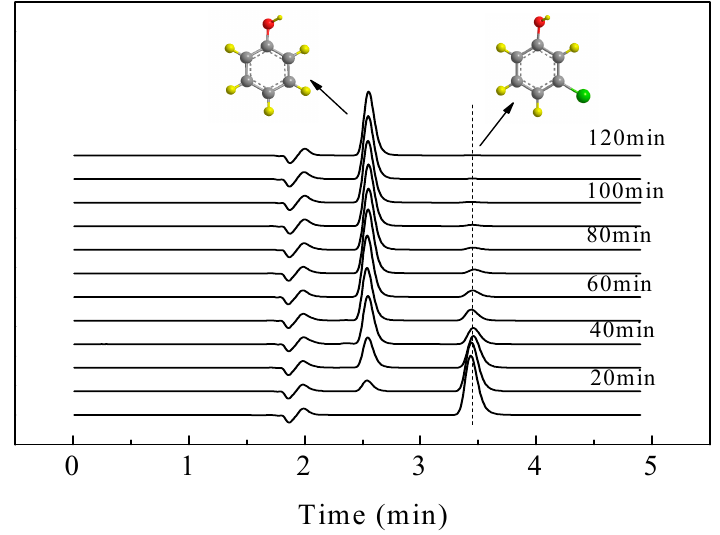
Figure 8. HPLC spectra of sample solution with different reaction time during the ECH of 3-CP.